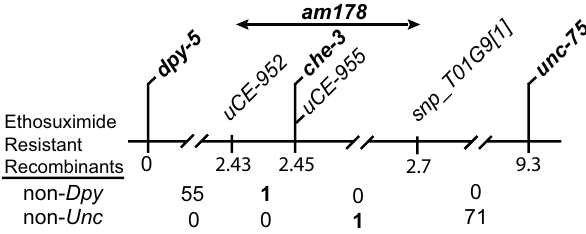
Figure 2. Positioning the am178 mutation. The horizontal line represents a portion of Chromosome I. Genes that can be mutated to cause visible phenotypes and SNP markers are shown above; map units are shown below. From dpy-5 am178 /CB4856 hermaphrodites, we selected 56 ethosuximide resistant, non-Dpy self-progeny. From am178 unc-75 /CB4856 hermaphrodites, we selected 72 ethosuximide resistant, non-Unc self-progeny. An analysis of SNP markers in these strains positioned the recombination events in the intervals shown below. The double-headed arrow indicates a 250 kBp interval between the SNP markers uCE-952 and snp_T01G9 [ 1 ] that contains am178 .